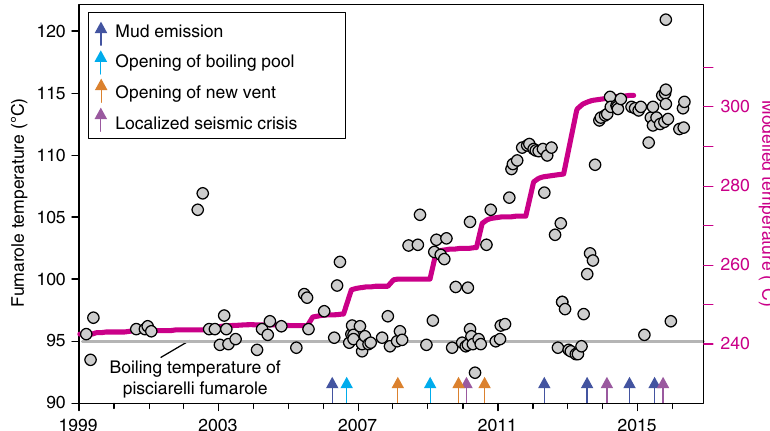
Figure 6 | Discharge temperature at the Pisciarelli fumarole compared with the modelled temperature. The temperature at the Pisciarelli fumarole (gray dots) increased from the boiling temperature (95 (cid:2) C) in 2005–2006 to 115–120 (cid:2) C in 2015. During the same time interval, temperature increased of only 3–4 (cid:2) C at the highest temperature fumarole BG, implying clustering of hydrothermal influx on the eastern outer slope of Solfatara crater, where Pisciarelli is sited (Fig. 3). At Pisciarelli, localized low-magnitude seismic swarms 20 , a weak phreatic activity (mud emission, opening of boiling pools and new vents), and a strong increase in the fumarole flow rate accompanied the temperature increase. The variation occurs concurrently with the increasing temperature of the CFc hydrothermal system modelled in Simulation 2 (magenta line; that is, average temperature inside the yellow box in Fig. 4).